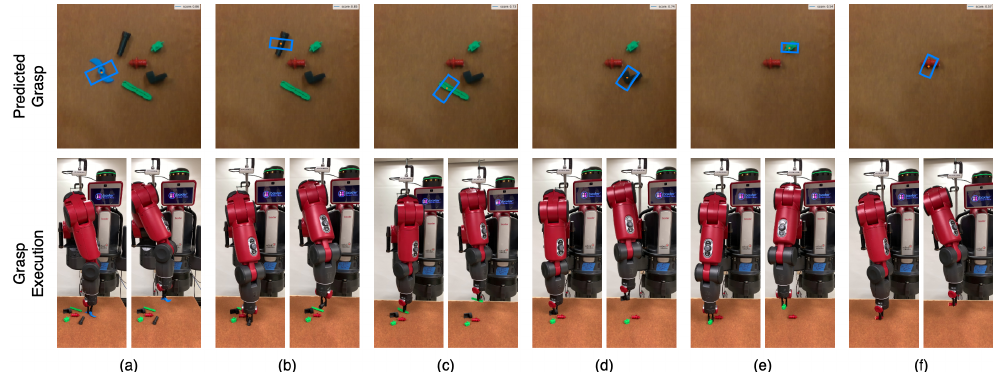
Figure 15. Visualization of the adversarial objects clutter scene removal task in the real world using our GR-Convnet model trained on Cornell dataset. See attached video for a complete run. ( a – f ) show the grasp pose generated by inference module (top), robot grasping the object (bottom left), and robot retracting after successful grasp (bottom right) for each object.